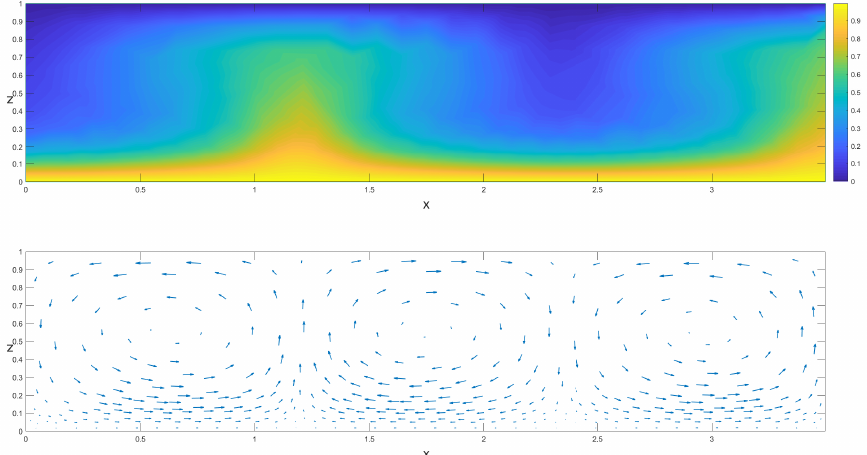
Figure 7. Isotherms and velocity field of the numerical solution obtained with finite elements; R = 5000 and Γ =